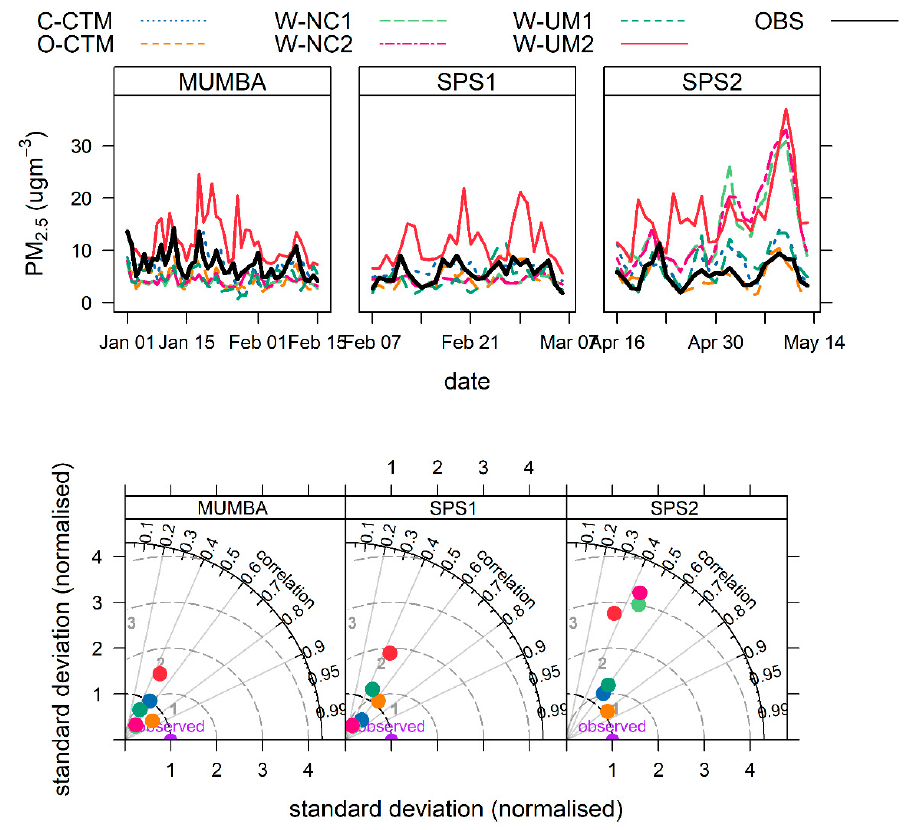
Figure 8. Composite time series of daily observed and modelled PM 2.5 during each campaign (upper panel) and Taylor diagrams for each campaign period (lower panel). Table 3. Summary statistics for daily PM 2.5 concentrations in µgm − 3 are listed for each model and each campaign including mean and standard deviation (Sd); normalized mean bias (NMB); normalized mean error (NME) and correlation coefficient (r).